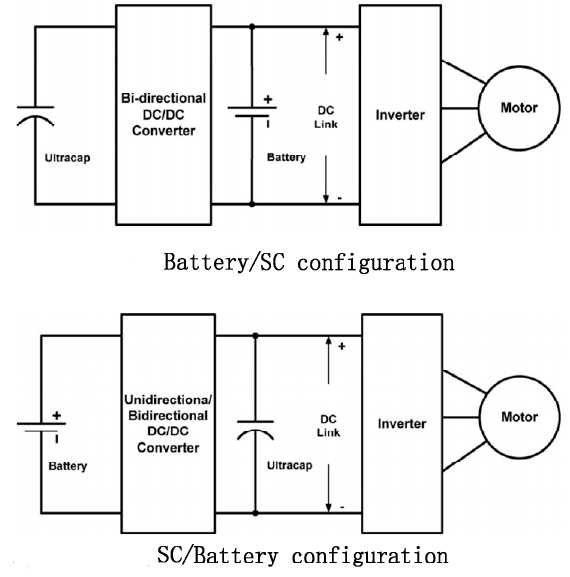
Figure 16. Two configurations of semi-active HESS.